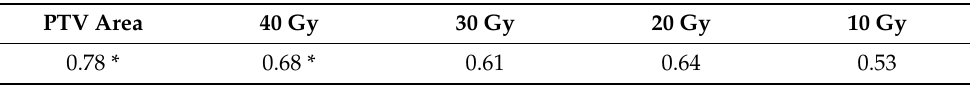
Table 2. Mean temperature increase in the PTV area obtained for the examined patients for each of the isodoses.